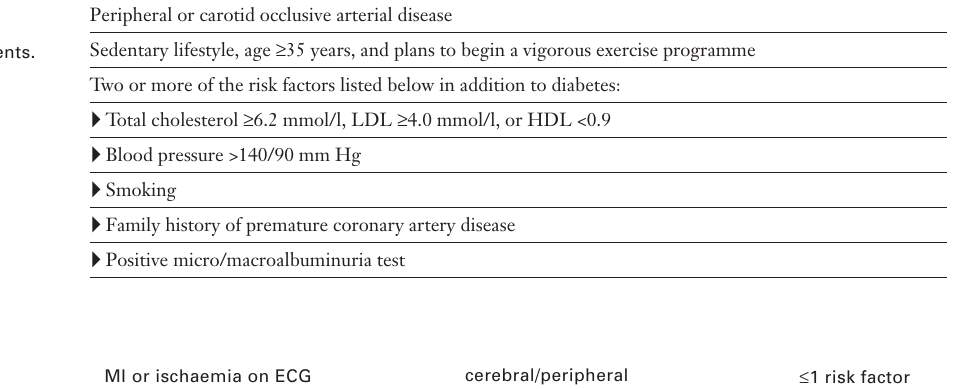
Cardiac testing algo- rithm for the asymp- tomatic diabetic pa- tient.